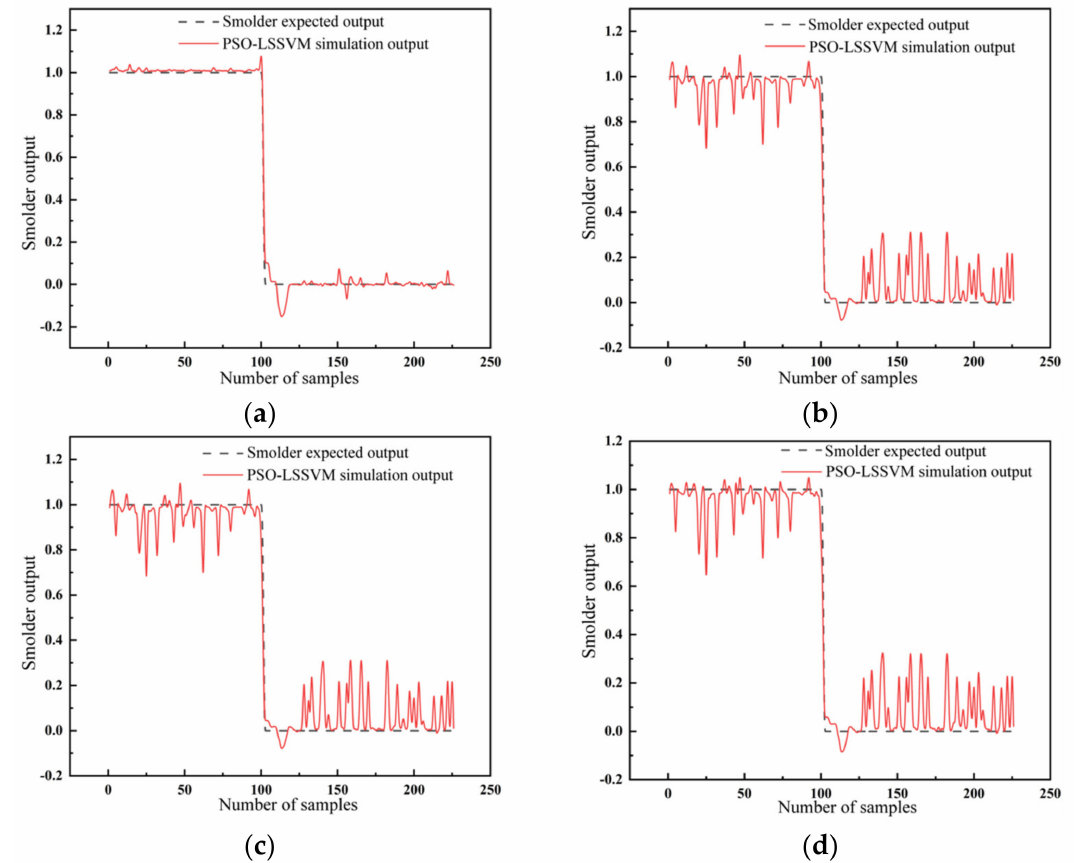
Figure 11. The output results of smolder with the LSSVM for different kernel functions: ( a ) radial basis kernel function; ( b ) sigmoid kernel function; ( c ) polypolynomial kernel function; ( d ) linear kernel